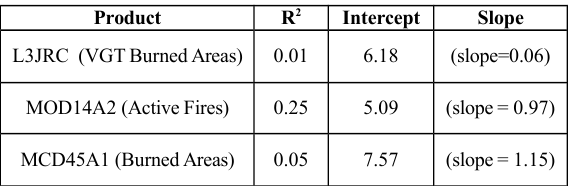
Table 1. Accuracy in detection of burned areas at regional scale of global products.